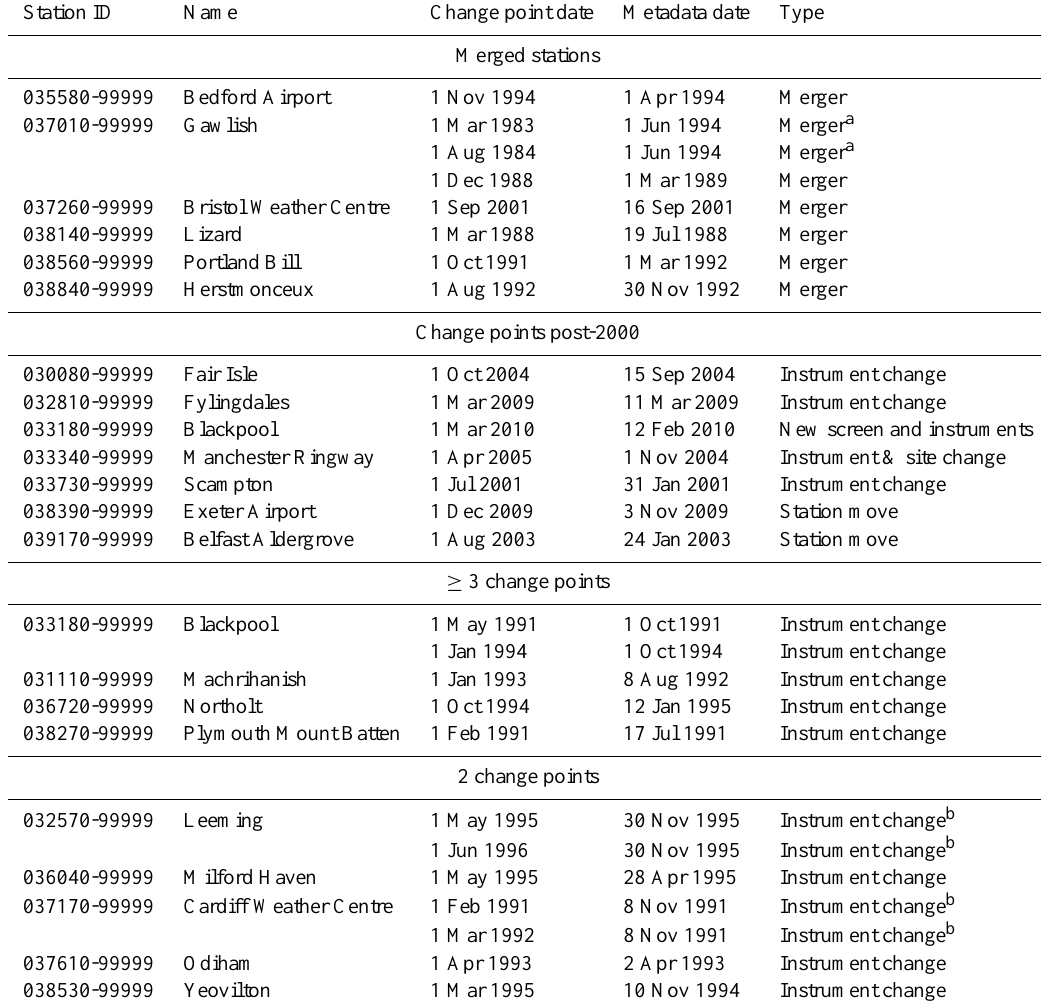
Table 2. Proposed change points from PHA which are close in date to changes in the station location or instrumentation as indicated in the